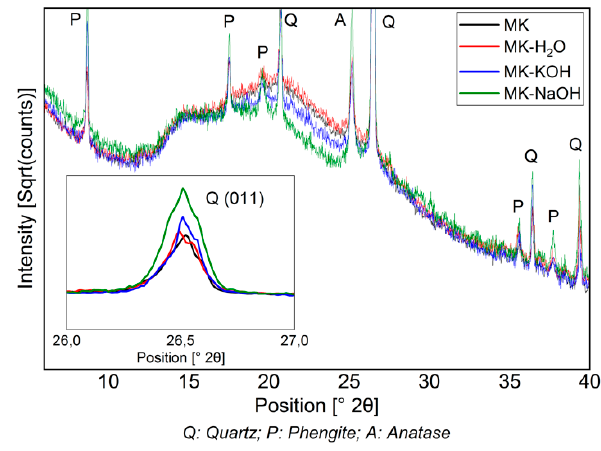
Figure 3. Diffractogram (CuK α ) of MK compared to those of insoluble residues of MK treated with different solutions. The decrease in the X-ray amorphous hump and the enrichment of crystalline phases (quartz peak (011) is highlighted in the enlarged range between 26–27° 2 Θ ) can be seen.